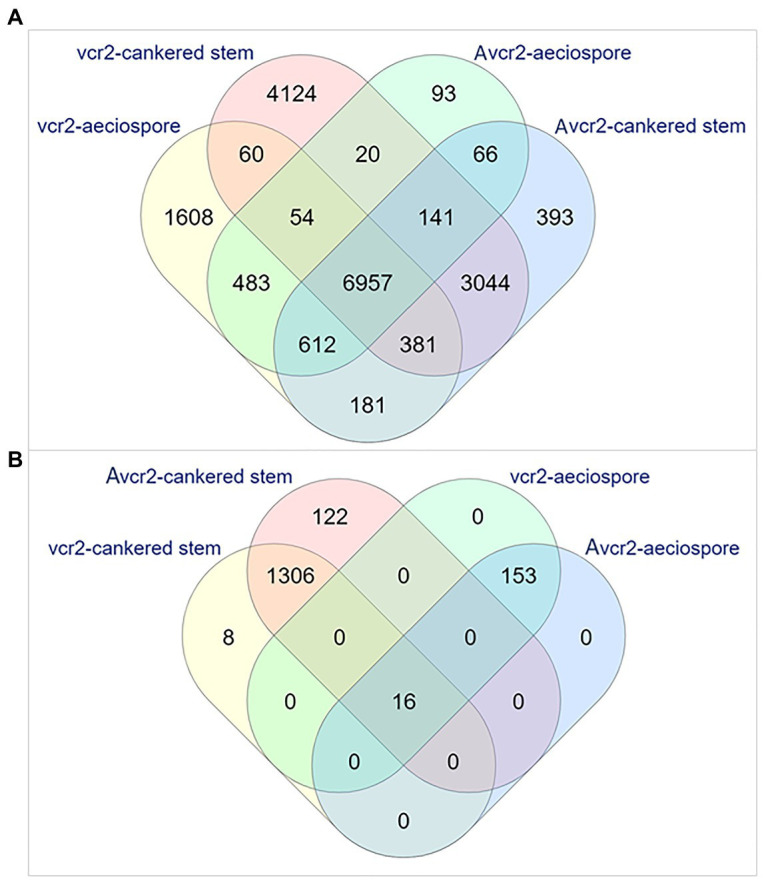
Venn diagrams representing numbers of the expressed unigenes. The expressed unigenes were counted in aeciospore and cankered stem with FPKM > 1. (A) Overlap of total genes expressed in vcr2 and Avcr2 pathotypes. (B) Distribution of differentially expressed genes (DEGs) by comparison of vcr2 with Avcr2.